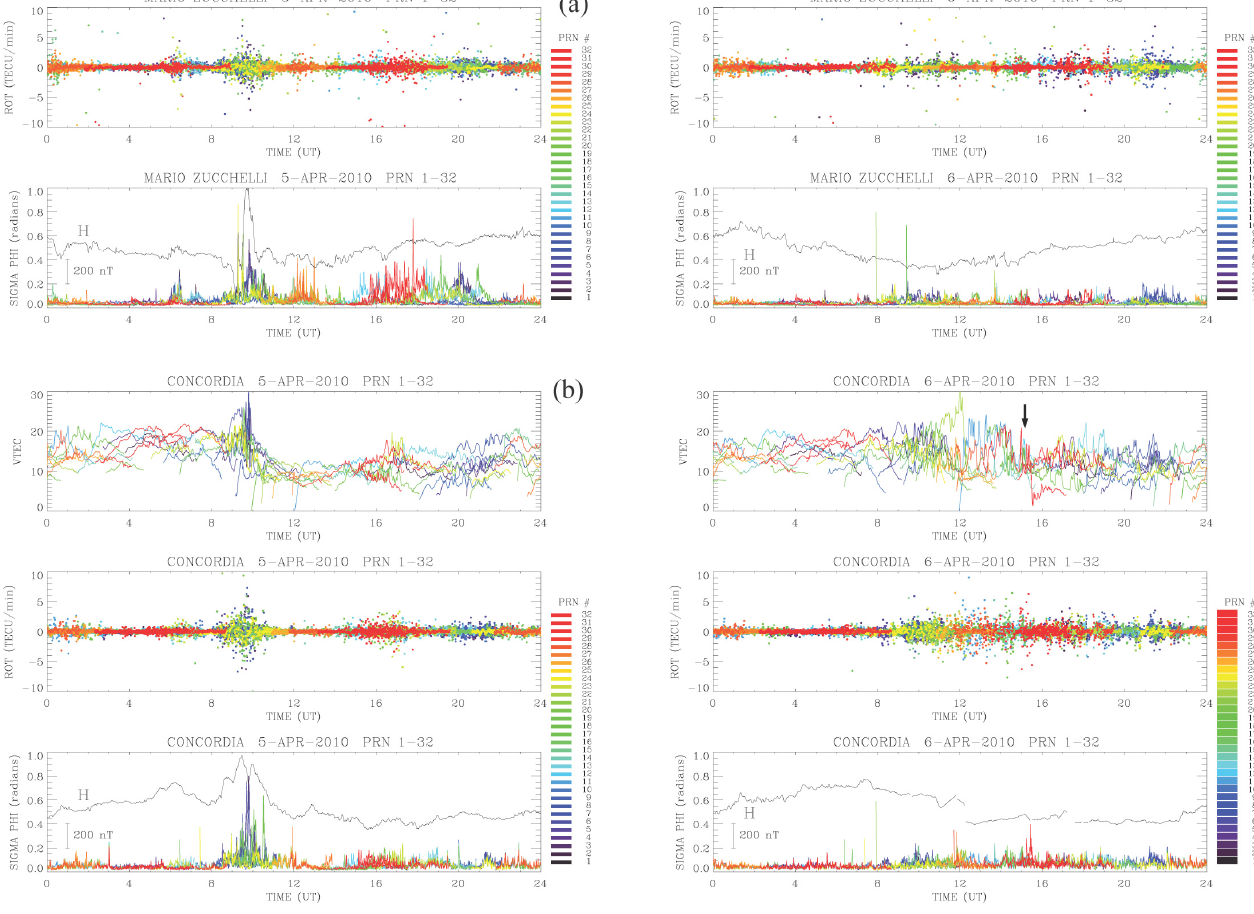
Fig. 7. The rate of TEC (ROT) change and phase scintillation index σ 8 observed at elevations above 20 ◦ in (a) Mario Zucchelli (top two rows) and (b) Concordia stations (three bottom rows) on 5 and 6 April 2010. TEC values projected to the vertical are shown for Concordia with an arrow pointing to large variations due drifting patches before 16:00UT on 6 April. Superposed in the scintillation panels is the H component of the ground magnetic